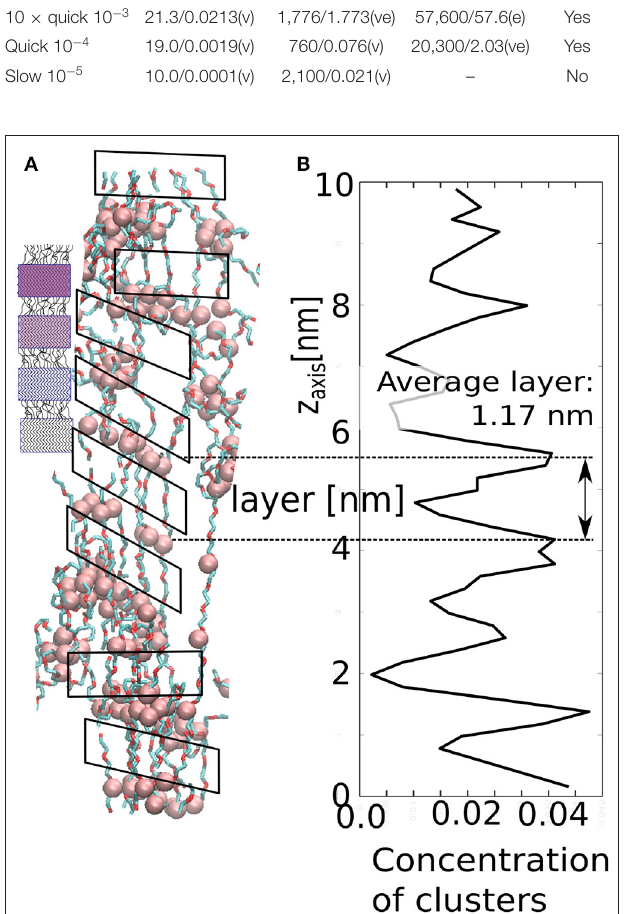
FIGURE 12 | Structure of the stretched network in our model: (A) small figure—schematic picture of spider silk; large figure—simulation snapshot; (B) local concentration of AA-clusters as along the